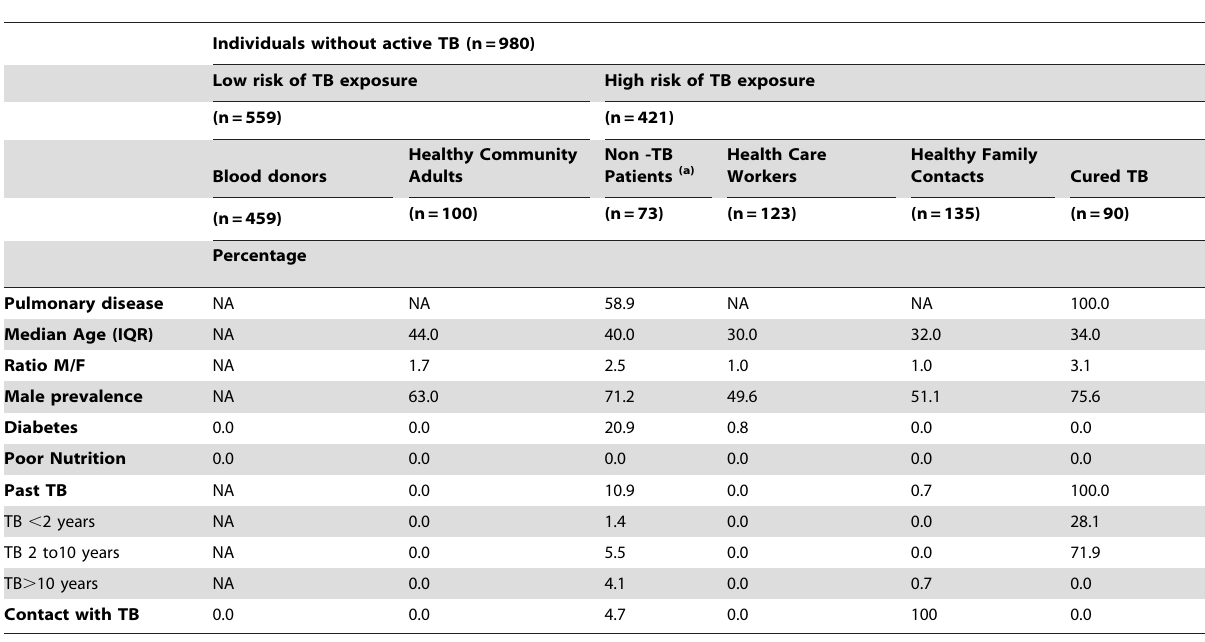
Table 4. Demographic and clinical characteristics of the non-active TB